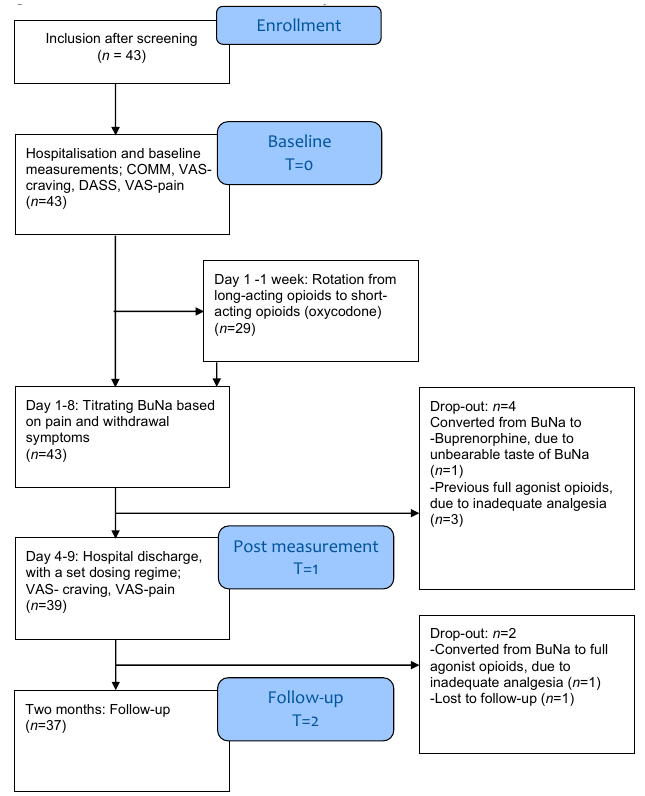
Figure 1. Consort flow chart of the study.